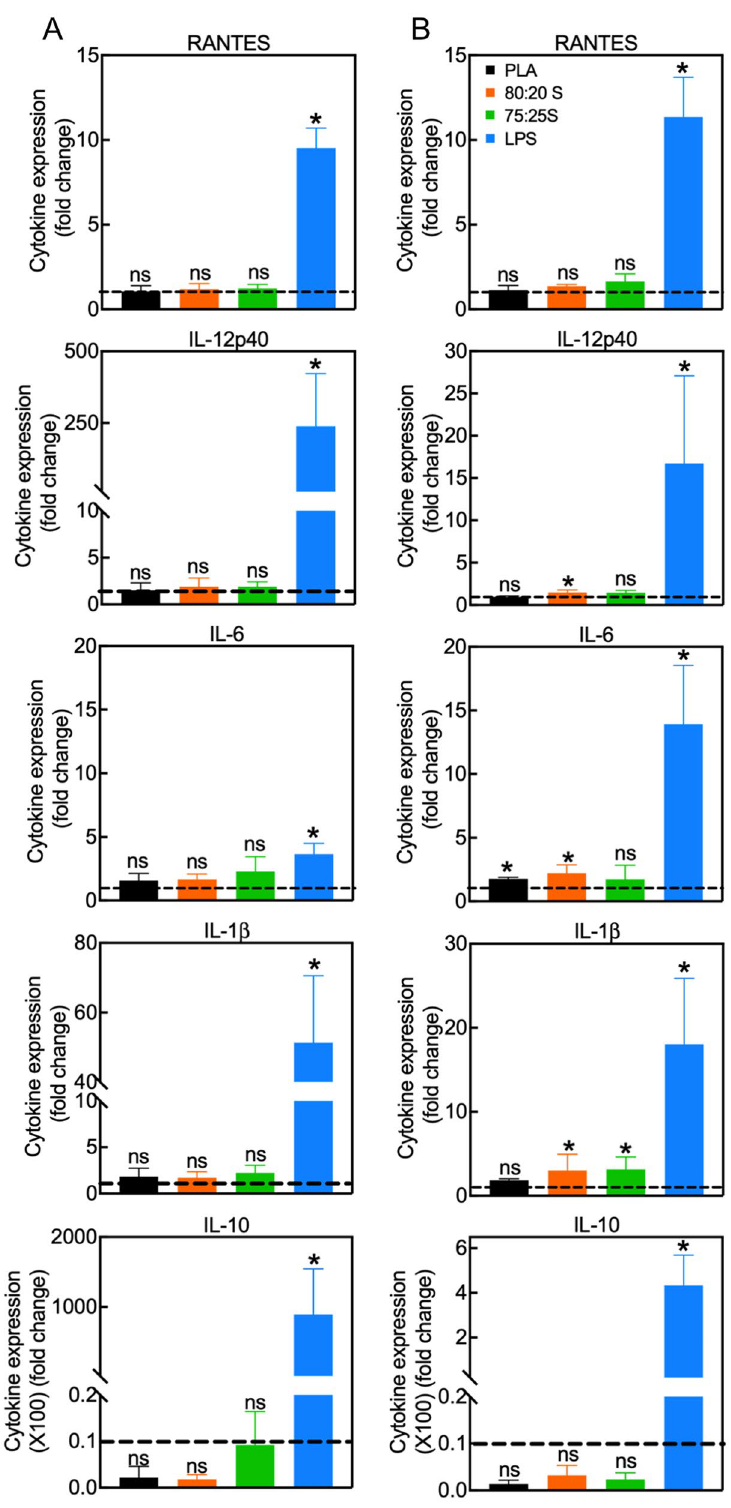
Figure 3. Quantification of cytokine expression in DC incubated with 3D scaffolds for 24 ( A ) or 48 h ( B ). Data show the mean ± SD of two independent RT-PCR measurements. All values were normalized to the expression levels of GAPDH. Gene expression in control DC (cultured on tissue culture dishes) was set to one (dashed lines). LPS-treated DC served as the positive controls. * p < 0.05, ns non-significant. Please note that the statistical analysis refers to the comparison with the